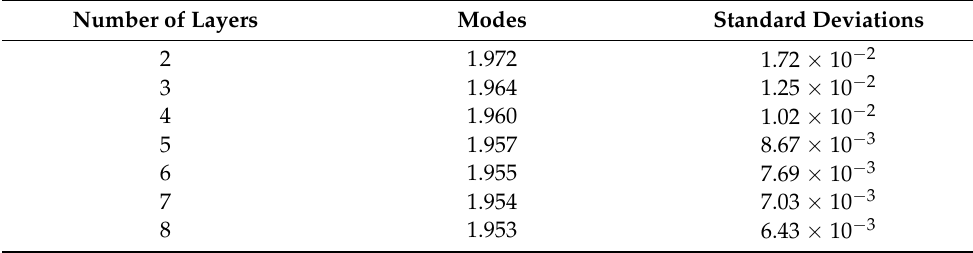
Table 3. Modes and standard deviations for the saturation density of 0.35 and the given number of